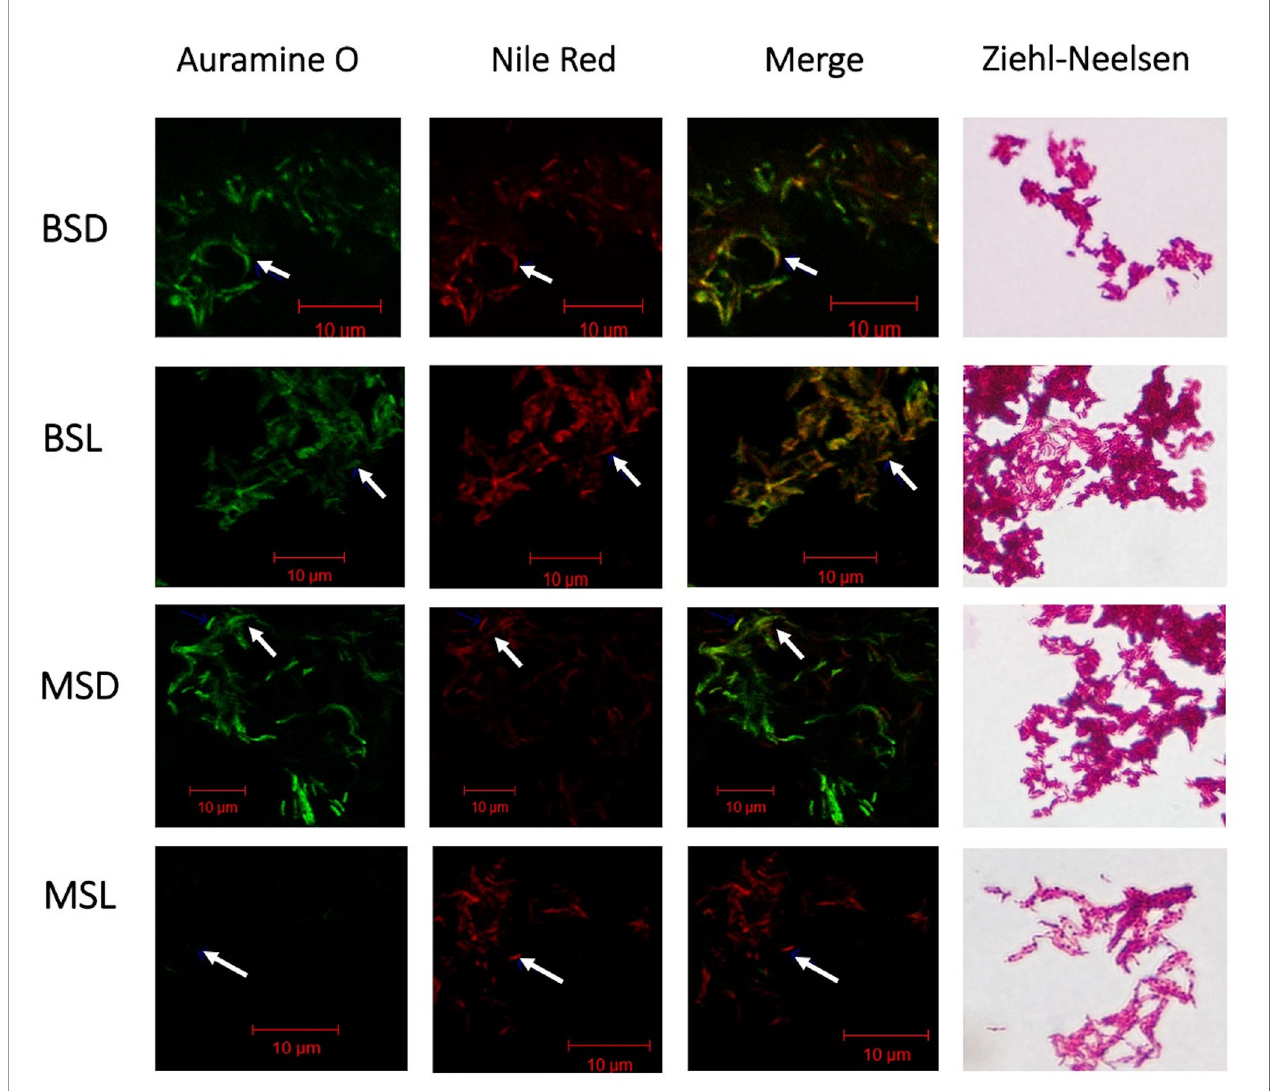
FIGURE 5 | Inactivation of the BCG_2177c gene allows neutral-lipid accumulation and decreases acid fastness in M. bovis BCG in the presence of fatty acids/ cholesterol at the stationary phase. Acid fastness and intracellular lipid accumulation were shown when the mutant strain (mtBCG) was grown at the stationary phase (MSL) in the presence of our lipid mixture. Mycobacteria were stained by auramine O and Nile Red and observed using confocal laser scanning microscopy. BSD (wtBCG cultured in dextrose); BSL (wtBCG cultured in lipids); MSD (mtBCG cultured in dextrose); MSL (mtBCG cultured in lipids). Merge, superposition of green and red fi